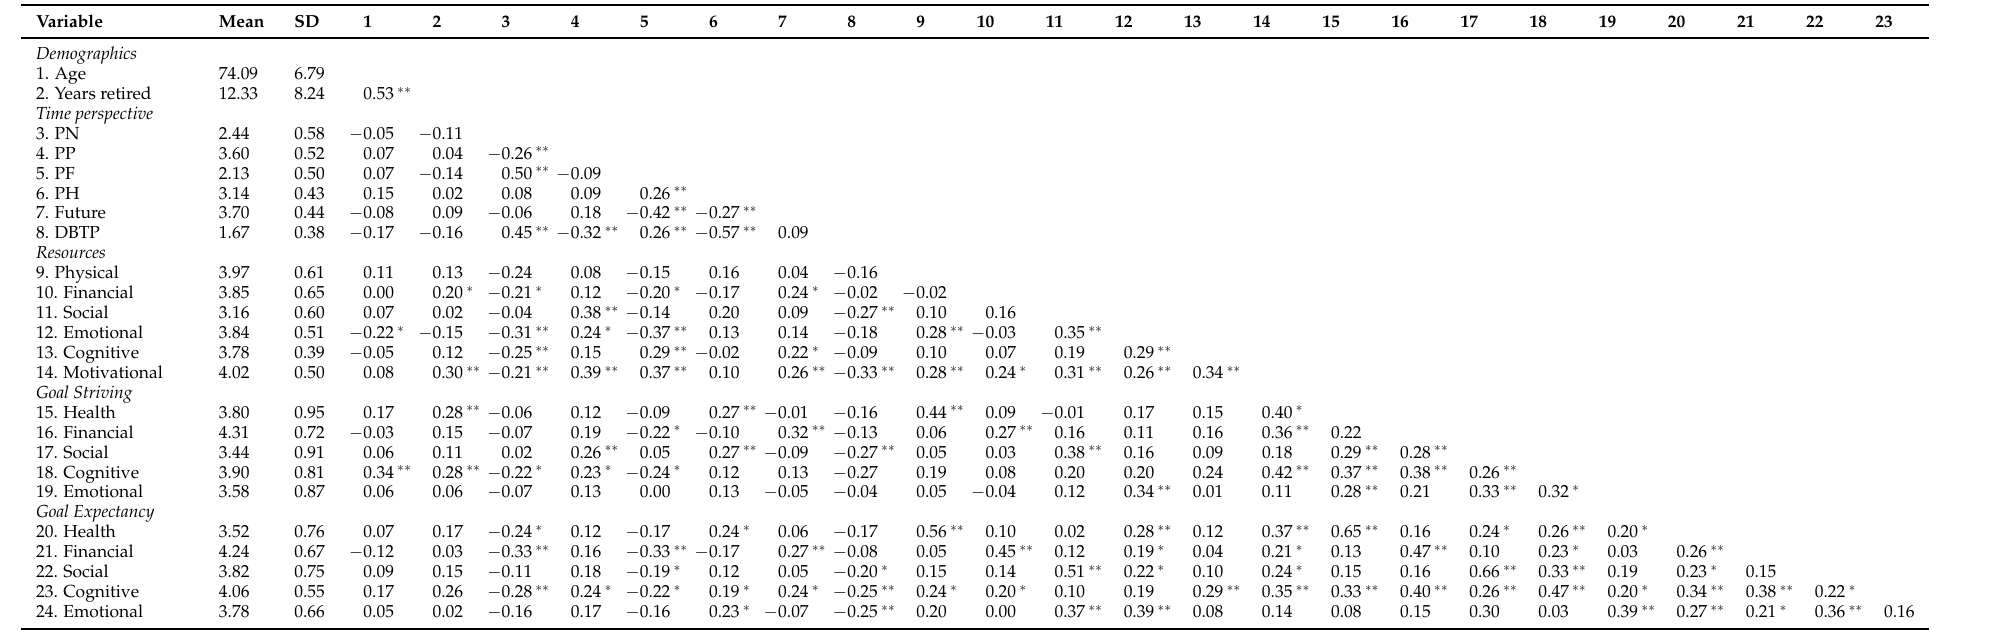
Table 1. Means, standard deviations, and correlation coefficients among key